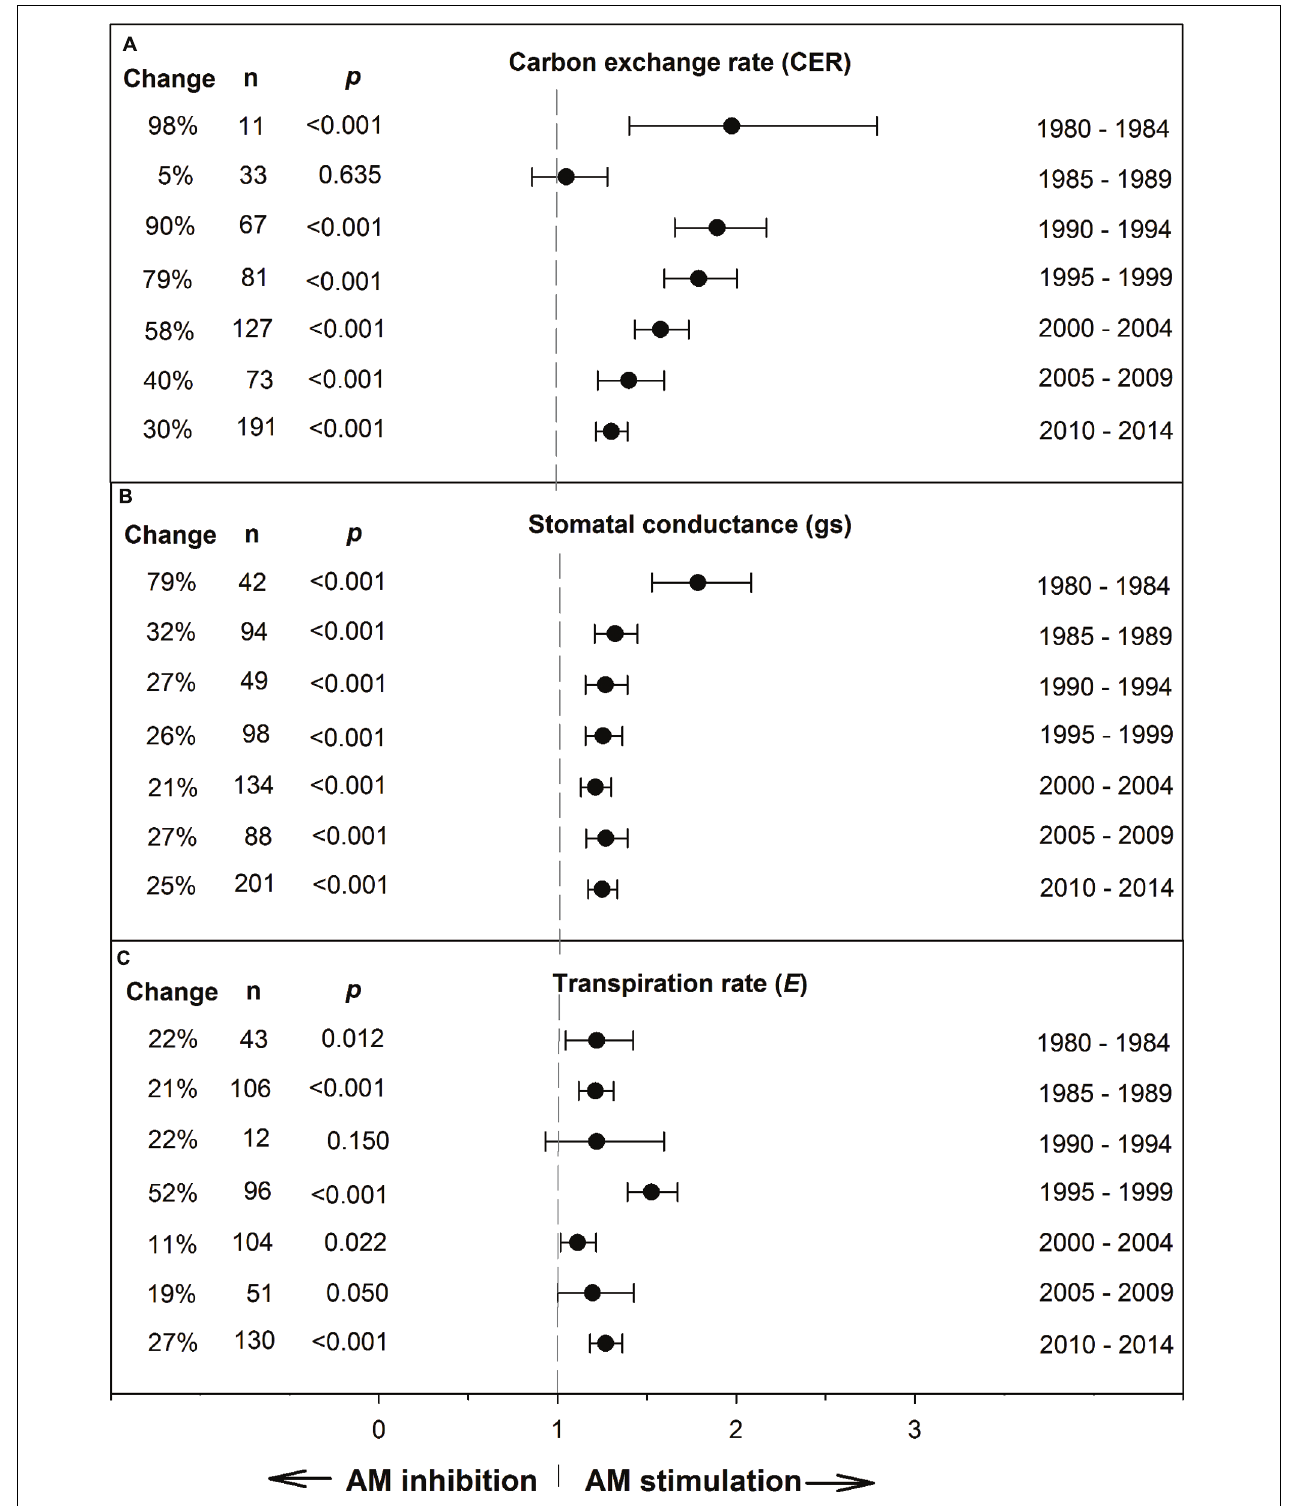
FIGURE 2 | Weighted summary effect sizes (response ratios) and 95% confidence intervals for AM influence on foliar carbon exchange rate (CER) (A), stomatal conductance ( g s ) (B), and transpiration rate ( E ) (C) over time (chronology moderator). Change refers to raw percentage increase in the gas exchange parameter induced by AM symbiosis. n is number of studies contributing to the effect size. p ≤ 0.05 indicates that the moderator level was significantly different than 0.